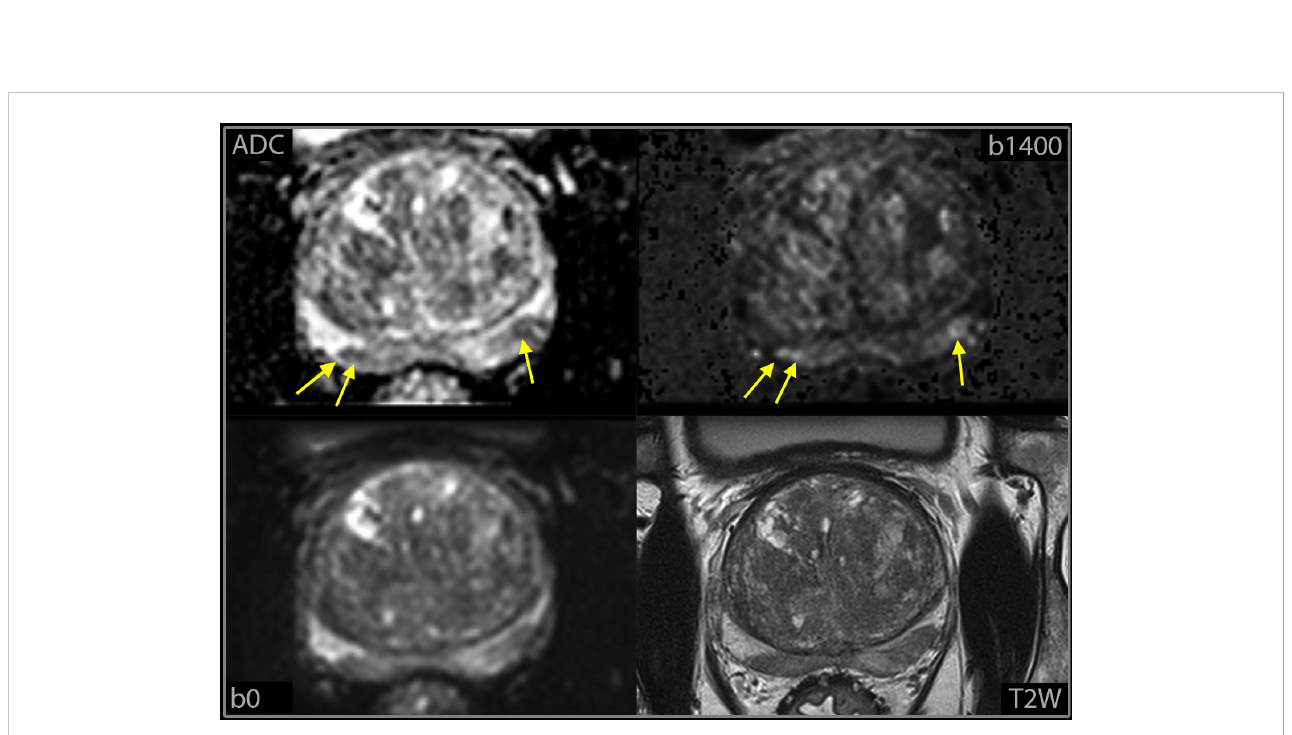
FIGURE 2 Example of small foci (yellow arrows) classi fi ed as equivocal at high-resolution DWI-only, with T2W sequence from mpMRI for